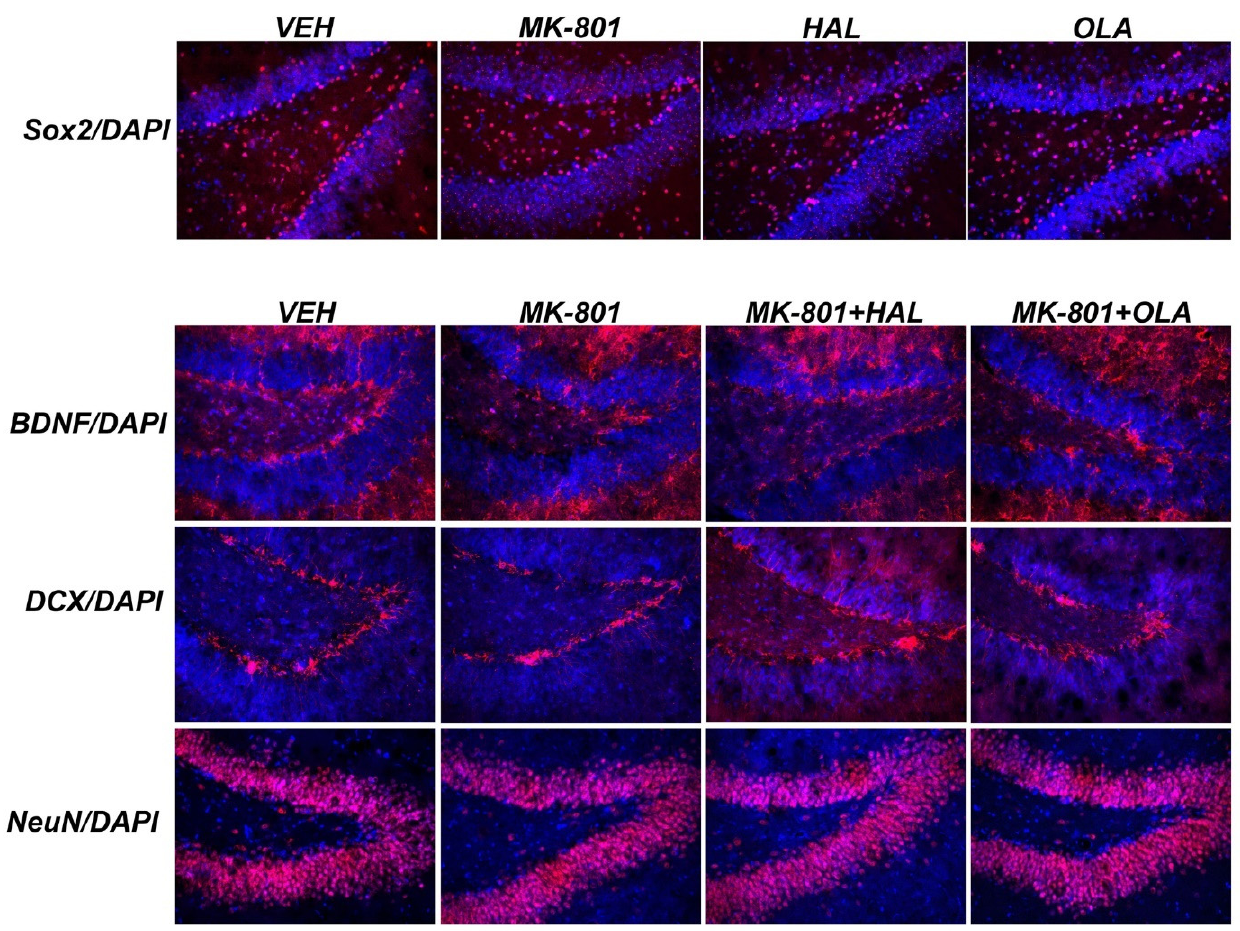
Figure 4. Representative immunofluorescent pictures show staining with anti-Sox2, anti-BDNF, anti-DCX, and anti-NeuN antibodies (red) and with DAPI for nuclei (blue) in the hippocampal part, gyrus dentatus. Magnification × 200.